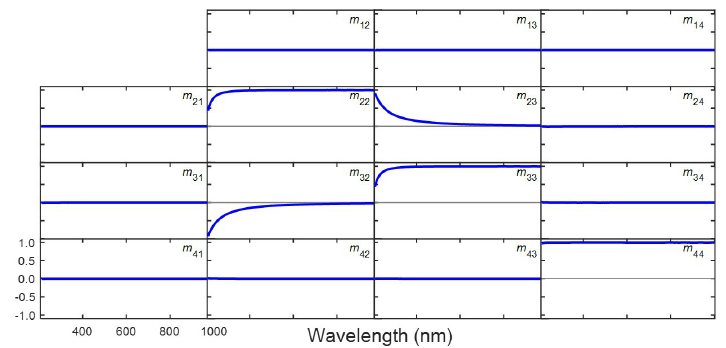
Figure 1. The transmission Mueller matrix of a D-glucose